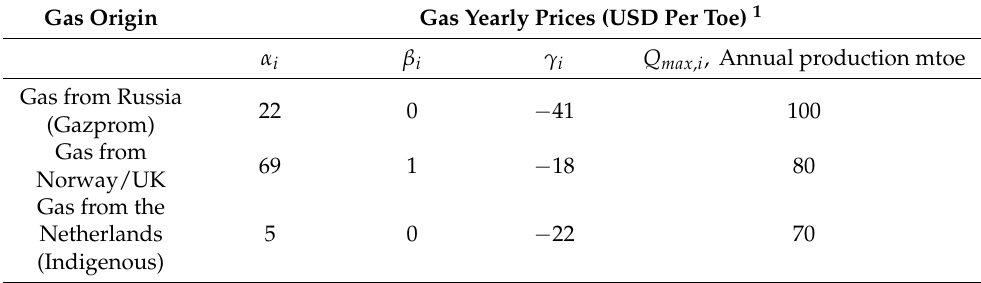
Table 3. Cost assumptions